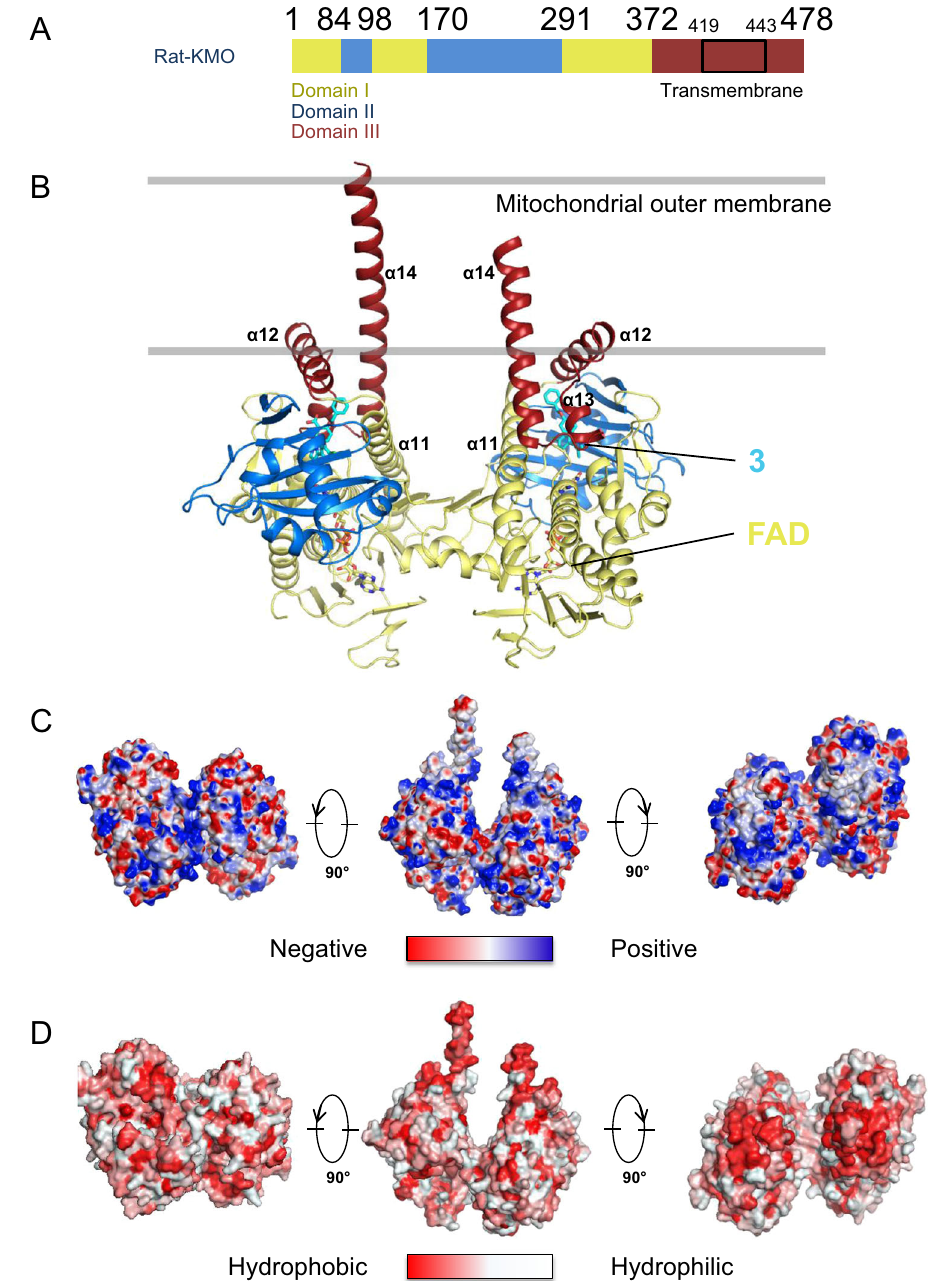
Fig. 2 Crystal structure of full-length Rat-KMO in meso . A Organisation of Rat-KMO domain. B The overall structure of Rat-KMO in complex with compound 3 in its membrane-embedded dimeric form. The two predicted transmembrane regions exhibit distinct features. One transmembrane region is inserted into the lipid bilayer while the other lays laterally across the membrane, forming part of the ligand binding pocket. Domains I, II and III are coloured yellow, blue, and red, respectively. Compound 3 and FAD are coloured cyan and yellow, respectively. Location of the membrane is shown in grey, as suggested from analysis of the sequence, electrostatics, and hydrophobicity. C Electrostatic potential and D hydrophobicity colouring of Rat-KMO show a non-polar surface in the α 12 helix, suggesting that it is partially embedded in the